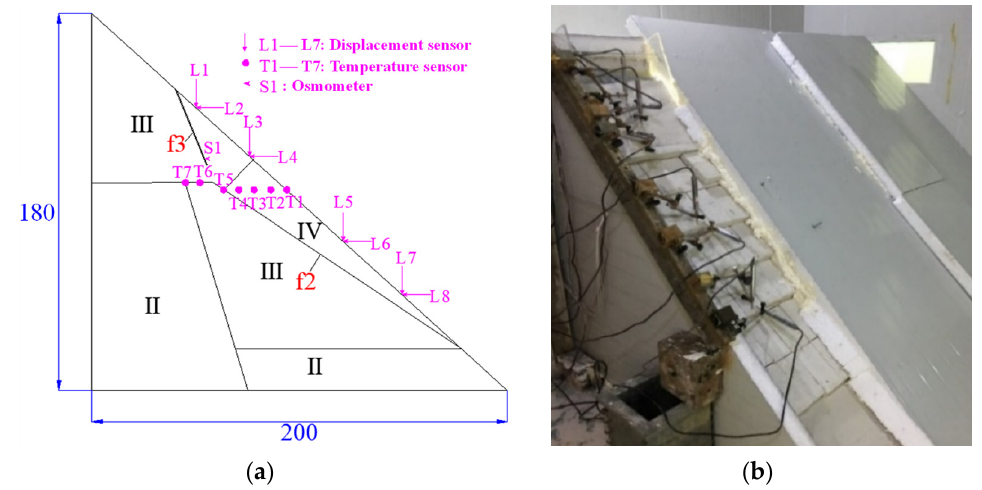
Figure 4. The installation of the indoor model testing equipment . ( a ) Design drawing (cm). ( b ) Com- pleted installation.